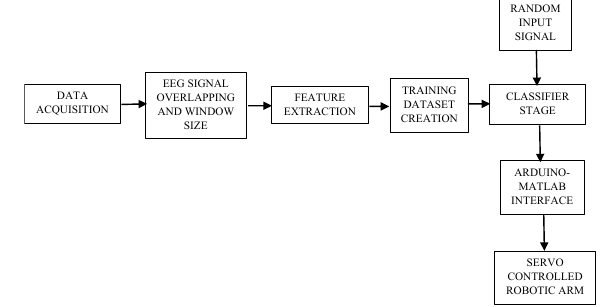
Fig. 1. Block Diagram of BCI Based Hand Assistant